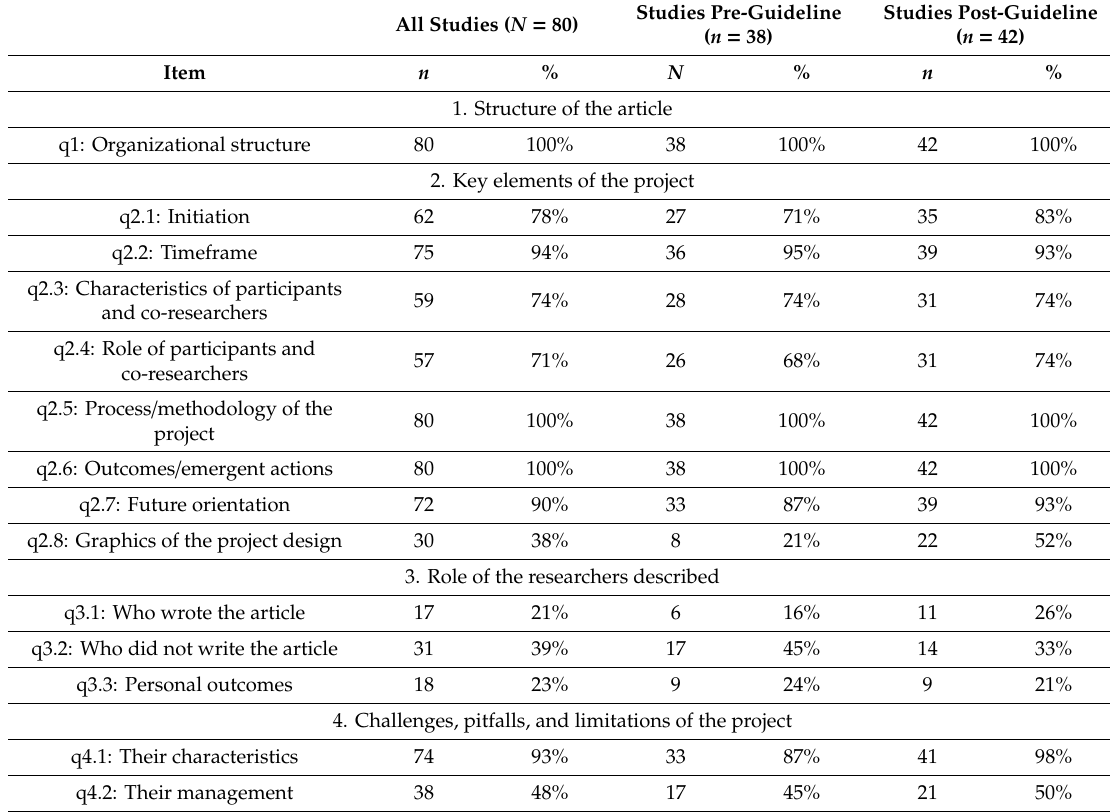
Table 1. Frequency of use of each reporting